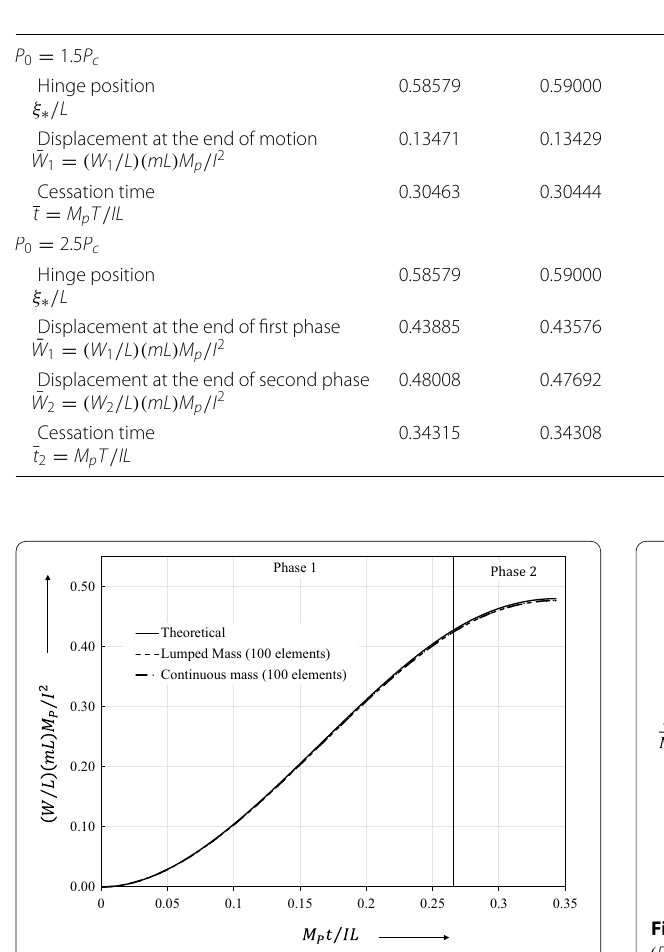
Fig. 9 Evolution of central displacement at ξ ∗ ( P 0 = 2.5 P c ) .